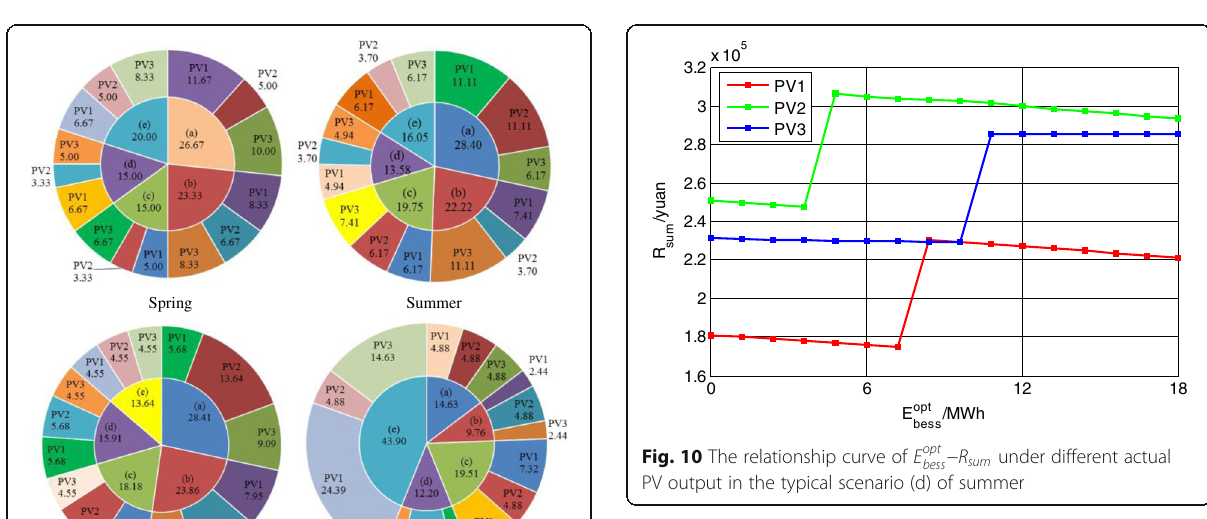
Fig. 10 The relationship curve of E opt PV output in the typical scenario (d) of summer